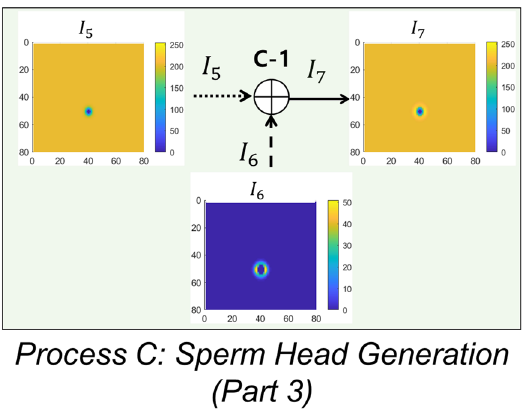
Figure 8. Diagram of sperm head image merging process. Images I 5 and I 6 are the inputs. The output is the simulated image of sperm head I 7 . I 5 and I 6 are added to generate I 7 (Process C-1).